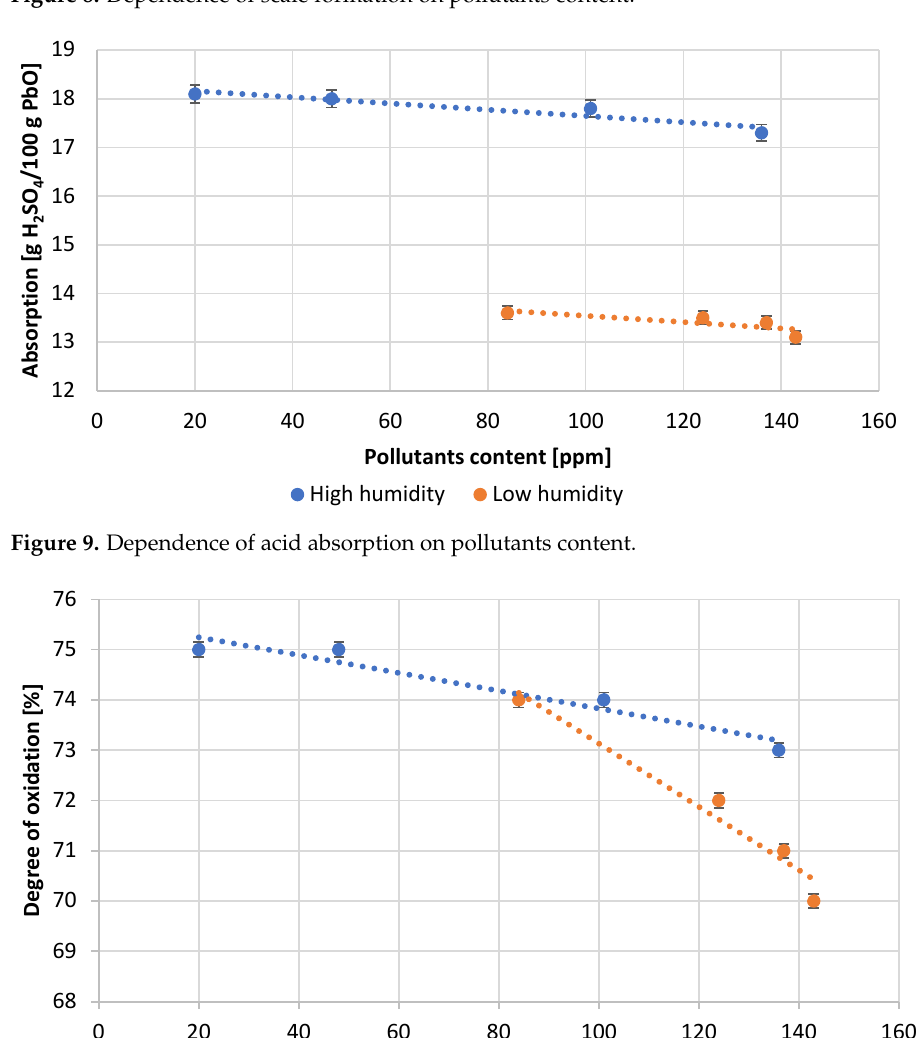
Figure 11. Dependence of bulk density of oxide on pollutants content. The dependence of the reactor load on the pollutants content allows us to notice a positive correlation for both high and low humidity of the air used (Figure 3). It should be noted that a greater influence of contaminants is observed for lower humidity. Figure 4 shows the dependence of the amount of water supplied to the reactor on the total contaminant content. The water input at high humidity conditions is much lower than at low humidity. The water molecules supplied stabilize the oxidation process and provide the oxidant needed for the reaction. As the amount of lead impurities increases, the amount of water consumed increases. Figure 5 shows the amount of lead supplied to the reactor during the production of lead oxide from lead with different levels of impurities for different humidity of the air used. Tests carried out at high air humidity allow the processing of a higher amount of